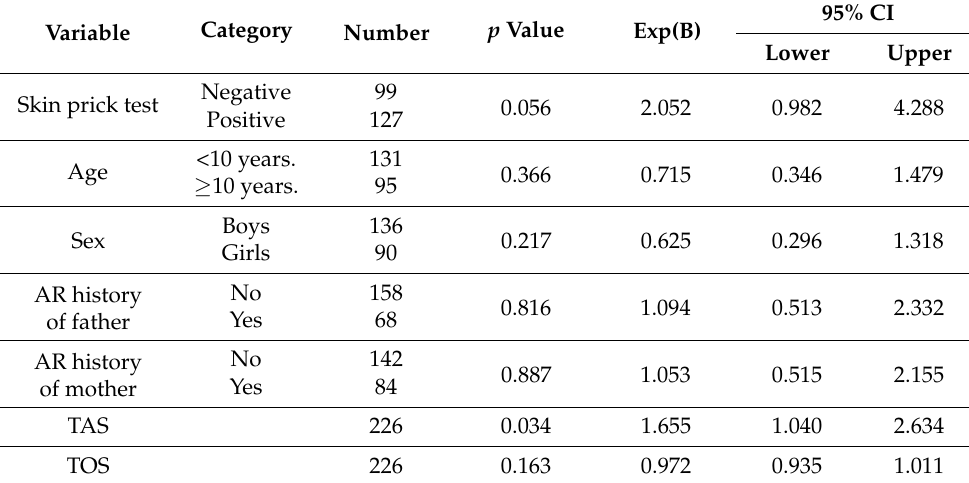
Table 5. Summary of multiple logistic regression of TAS/TOS levels in the group with symptom duration more than six